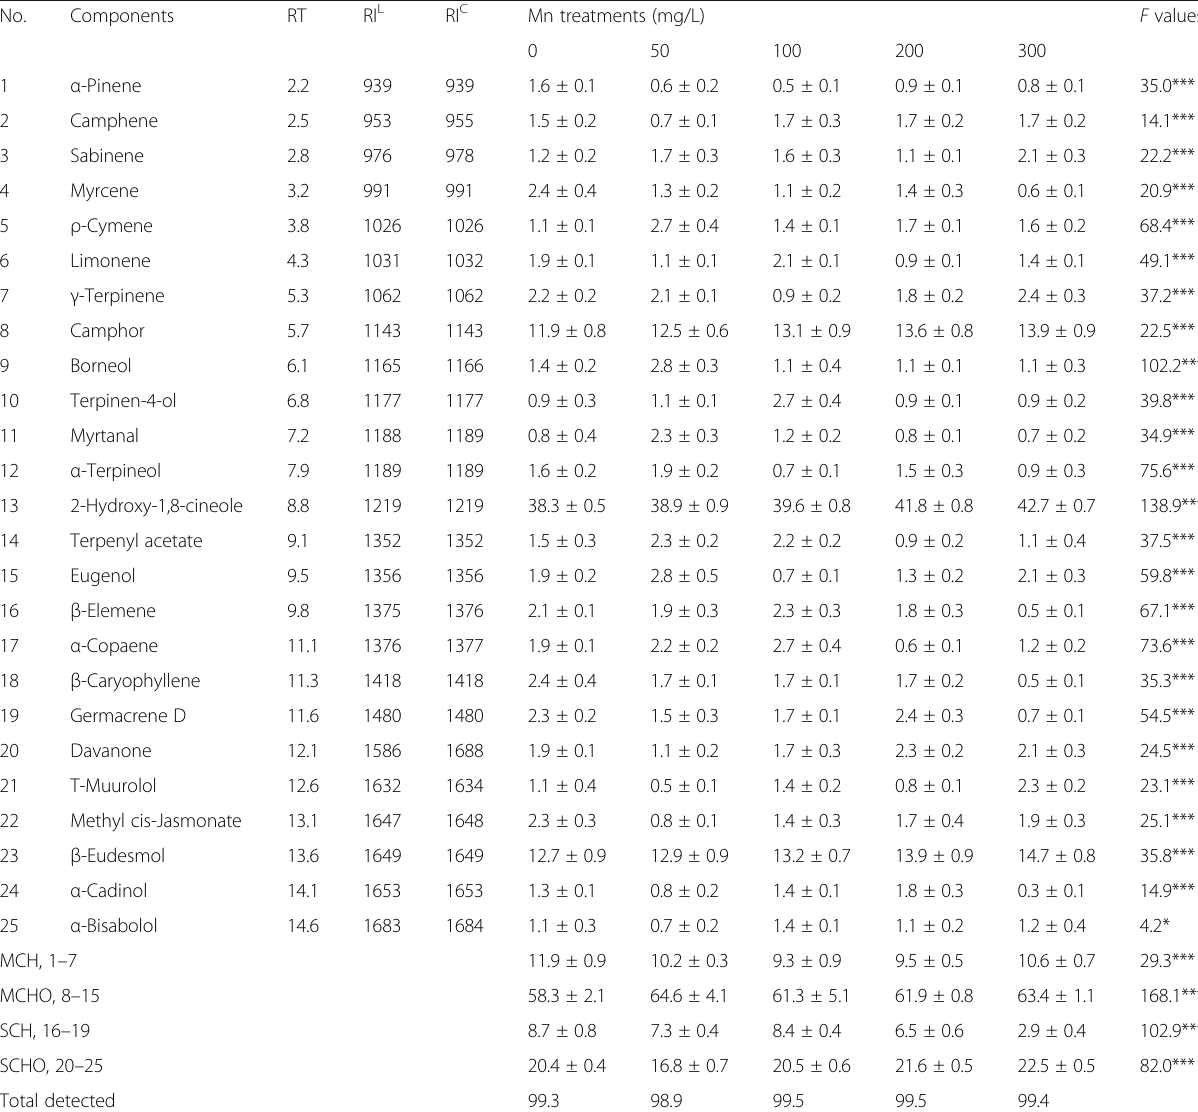
Table 6 Effect of Mn treatments on EO constituents